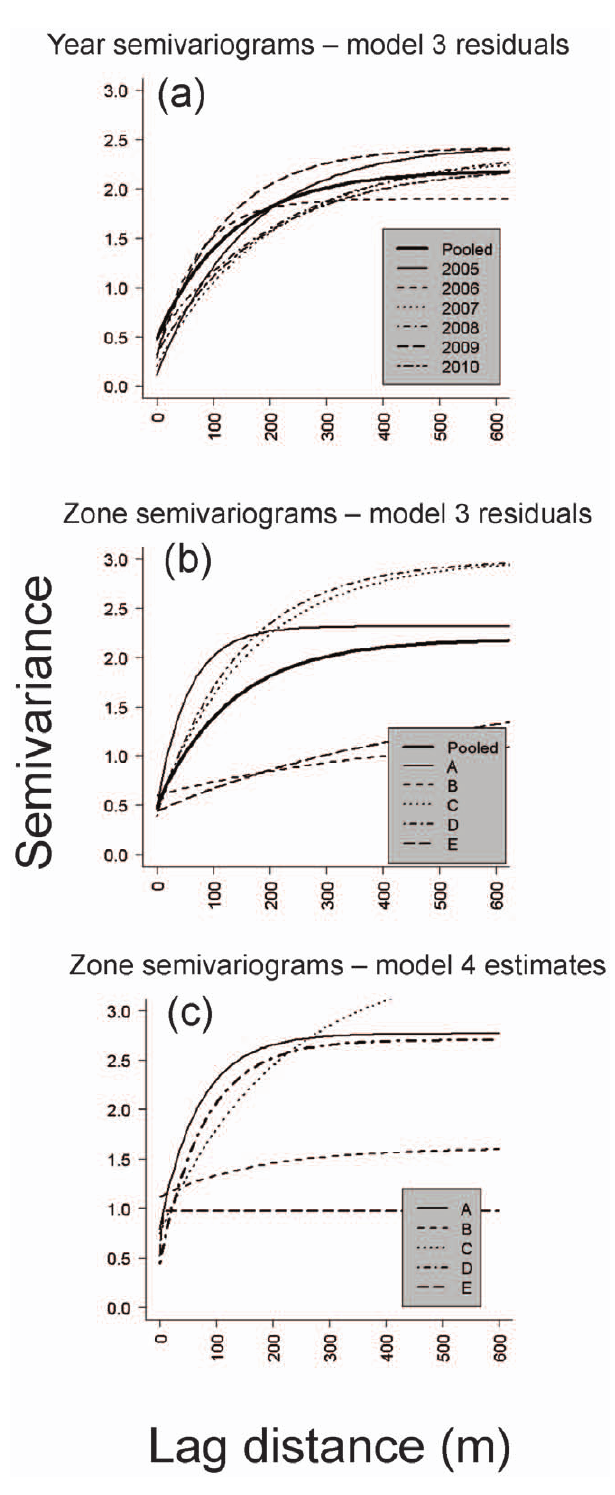
Figure 3. Semivariograms of camas density in the restoration site. In panels a and b, parametric exponential semivariogram models were fit to a) pooled and year-specific and b) pooled and zone-specific empirical models from model 3 residuals for the restoration site. In panel c, zone-specific posterior median estimates for partial sill and , w k ) obtained from model 4 were used. range covariance parameters ( s 2 k